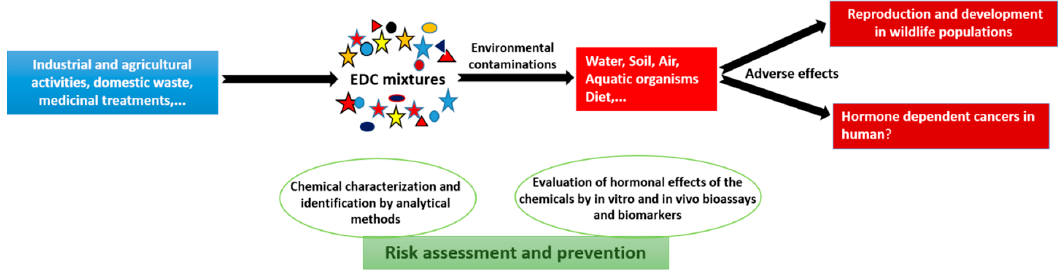
Figure 1. Risk assessment and chemical exposure prevention. Chemical mixtures such as endocrine- disrupting chemicals (EDCs), released from different sources, can be found in the environment and food. They should be monitored through analytical and screening approaches. New detection chemical